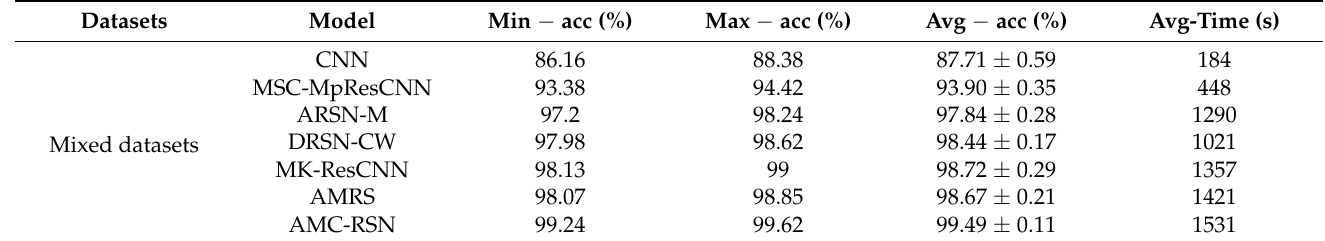
Table 6. Fault diagnosis results in gear.